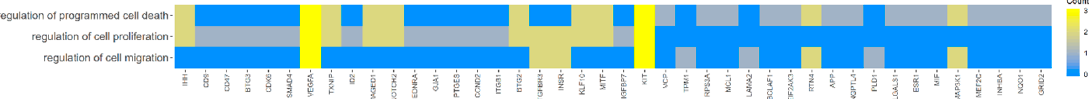
Figure 4. Heatmap showing the gene occurrence between differentially expressed genes that belong to the “cell proliferation”, “regulation of programmed cell death”, and “regulation of cell migration”. The red color is associated with gene occurrence in the GO Term. The intensity of the color is corresponding to the amount of GO BP terms that each gene belongs to. belonging to the analyzed ontology groups. The intensity of the edges reflects the strength of the interaction score (Figure 5).